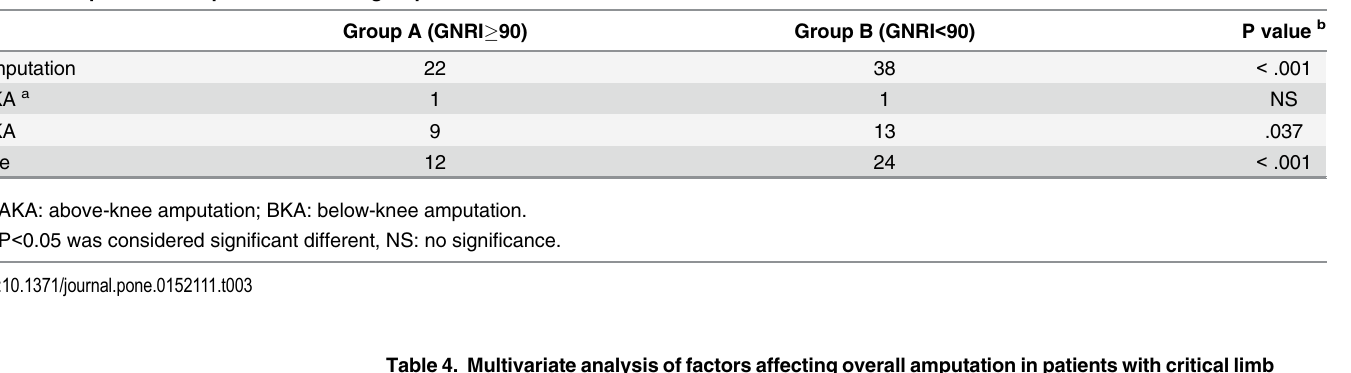
Table 3. Amputation comparison between group A and B.